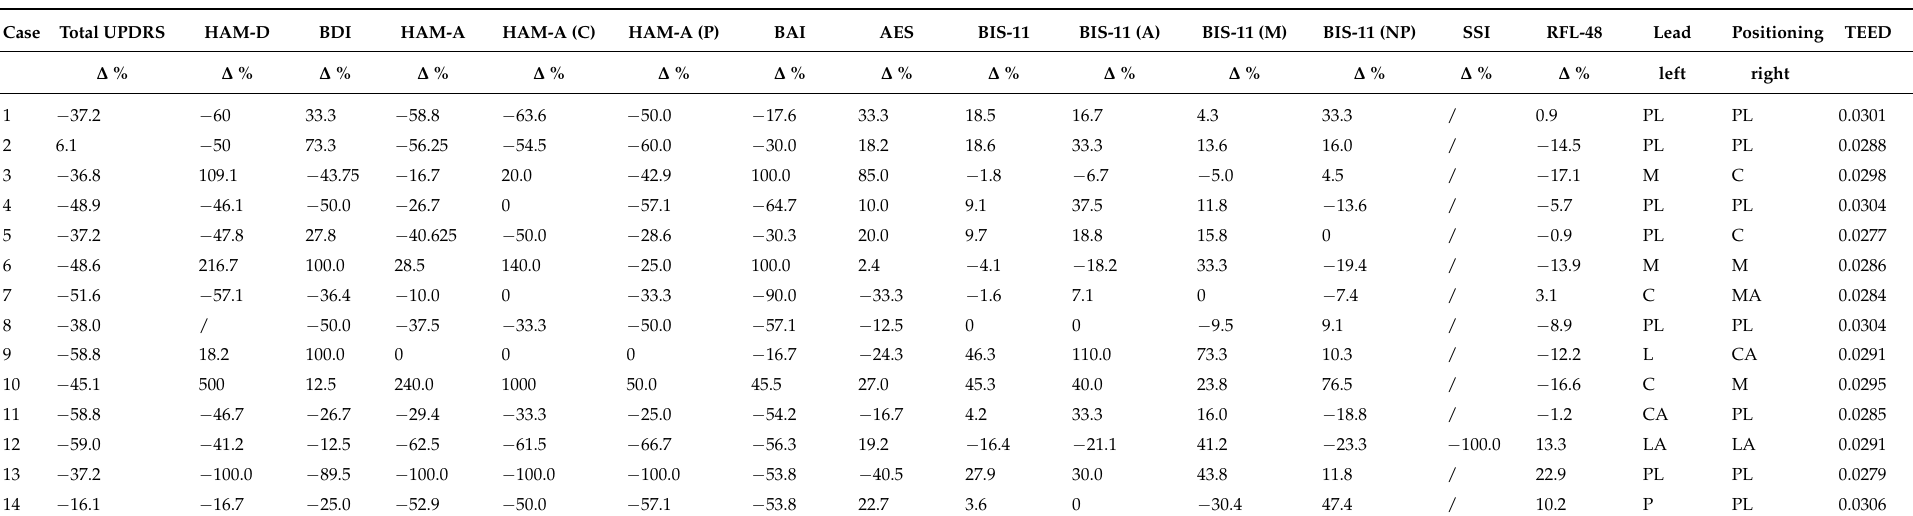
Table 3. Outlook of the results of the psychiatric scales, lead positioning, and